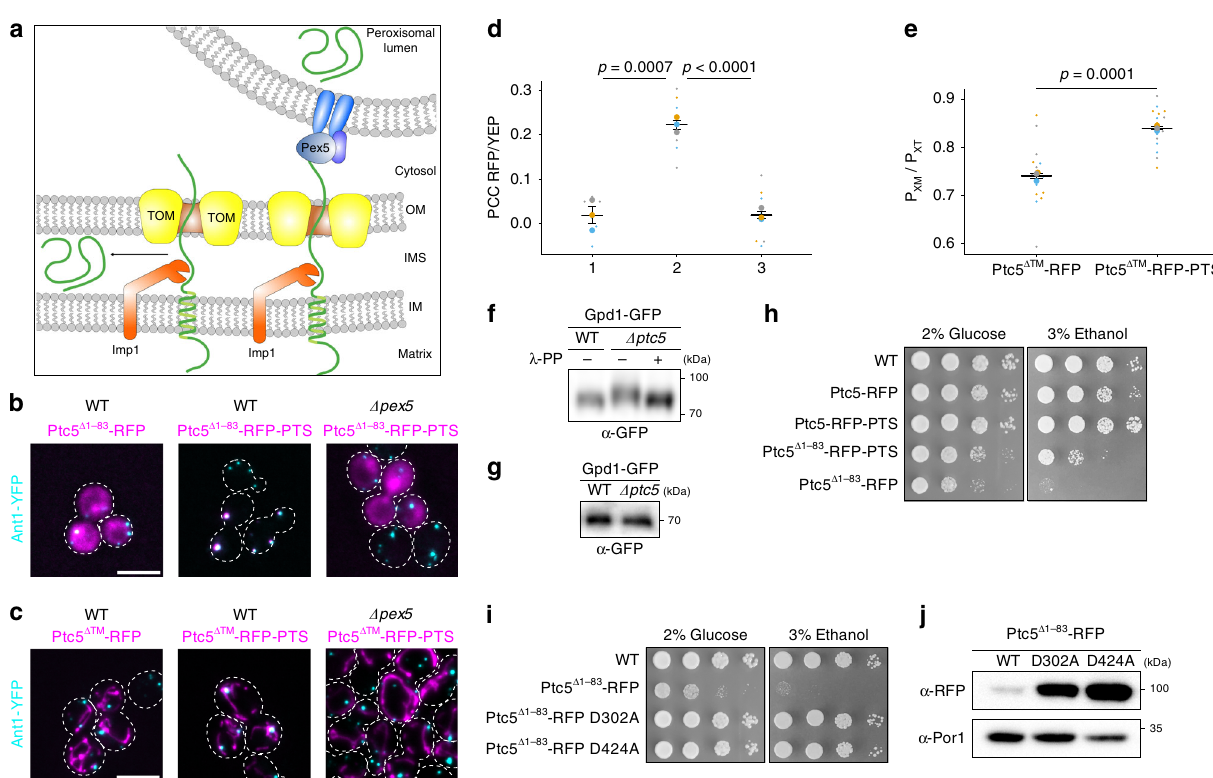
Fig. 5 A tug-of-war-like mechanism sorts Ptc5 from mitochondria to peroxisomes and prevents detrimental phosphatase activity in the cytosol. a Working model of the mechanism of Ptc5 sorting. Ptc5 (green) either localizes to the mitochondrial intermembrane space or translocates into the peroxisomal matrix after processing by Imp1 (orange). Translocation depends on Pex5 and other components of the peroxisomal protein import machinery (blue). b Fluorescence microscopic pictures of yeast cells expressing either Ptc5 Δ 1 – 83 -RFP or Ptc5 Δ 1 – 83 -RFP-PTS (magenta) together with the peroxisomal membrane protein Ant1-YFP (cyan) in indicated strains. White color indicates colocalization. Scale bar represents 5 µ m. c Ptc5 Δ TM -RFP or Ptc5 Δ TM -RFP- PTS were co-expressed with Ant1-YFP in indicated strains. Subcellular localization was determined by fl uorescence microscopy. White color indicates colocalization. Scale bar represents 5 µ m. d Correlation between the signal of Ptc5 Δ TM -RFP or Ptc5 Δ TM -RFP-PTS and of Ant1-YFP was quanti fi ed. PCC refers to the Pearson ’ s correlation coef fi cient. 1: Ptc5 Δ TM -RFP in WT, 2: Ptc5 Δ TM -RFP-PTS in WT, and 3: Ptc5 Δ TM -RFP-PTS in Δ pex5 . Quanti fi cations are based on n = 3 independent experiments. Each color represents one experiment. Error bars represent standard error of the mean. P -values were calculated with a two-tailed unpaired Student ’ s t -test. e Quanti fi cation of the fraction of peroxisomes contacting mitochondria (Px M ) in relation to the total peroxisome count (Px T ) of cells co-expressing Ptc5 Δ TM -RFP or Ptc5 Δ TM -RFP-PTS with Ant1-YFP, and the mitochondrial membrane protein Tim50 fused to CFP (Supplementary Fig. 5a). Association of Ant1-YFP containing foci with Tim50-CFP was counted in three independent experiments ( n = 3). Independent experiments are represented by different colors. Error bars represent standard error of the mean. P -values were calculated with a two-tailed unpaired Student ’ s t -test. f PhosTag SDS – PAGE of peroxisomal fractions derived from WT and Δ ptc5 cells expressing Gpd1-GFP (Supplementary Fig. 6a) was analyzed by western blot to determine the phosphorylation status of Gpd1-GFP. λ -PP indicates treatment with λ -protein phosphatase prior to PhosTag SDS – PAGE. g Samples shown in f were also analyzed by conventional SDS – PAGE and western blot to assure that migration differences result from altered phosphorylation. h , i Serial dilutions of indicated strains were spotted on SC-HIS medium containing either glucose or ethanol as carbon source. j Western blot showing the expression levels of Ptc5 Δ 1 – 83 -RFP and its phosphatase-dead derivatives D302A and D424A. Por1 served as a loading control. Source data are provided in the Source data fi